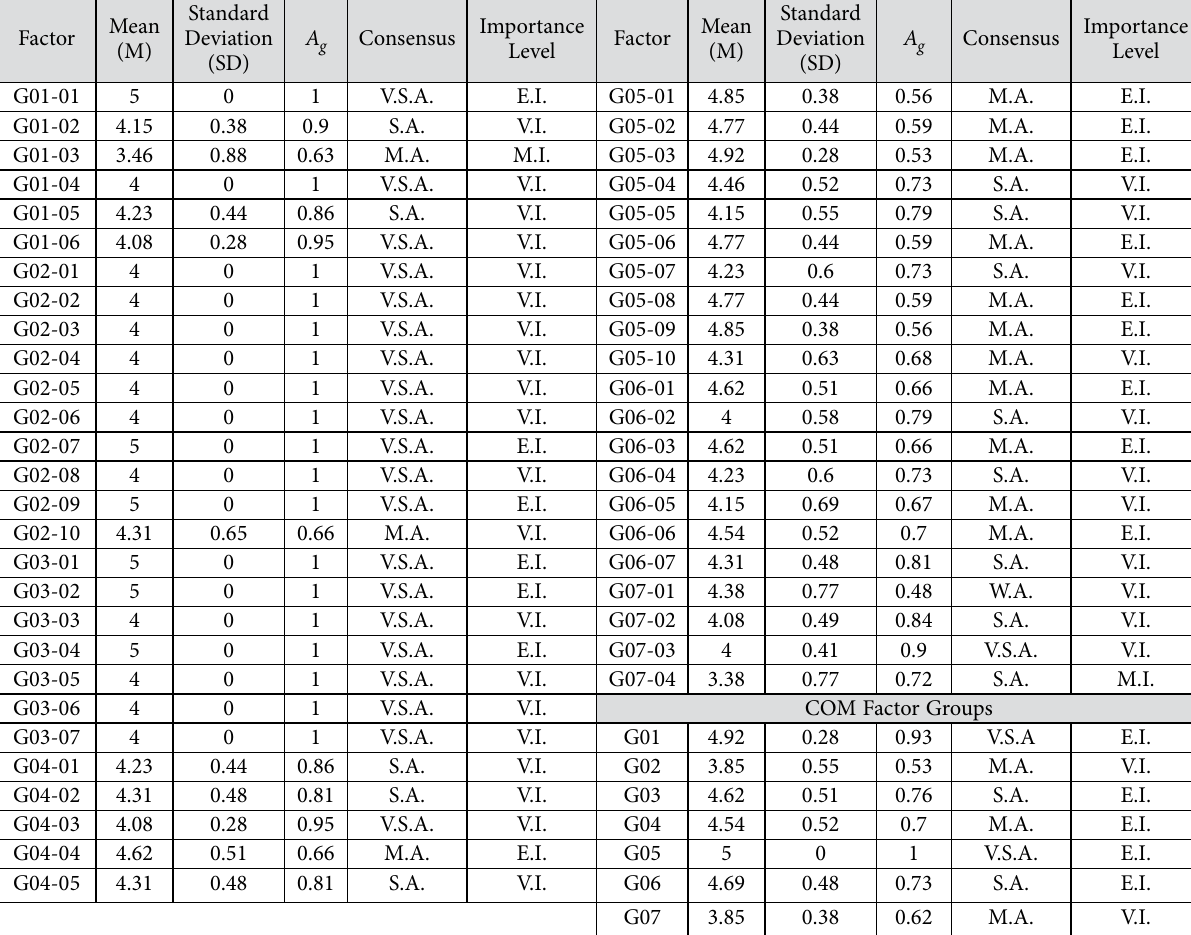
Table 7. Strength of agreement in the second round for the COM factors and groups